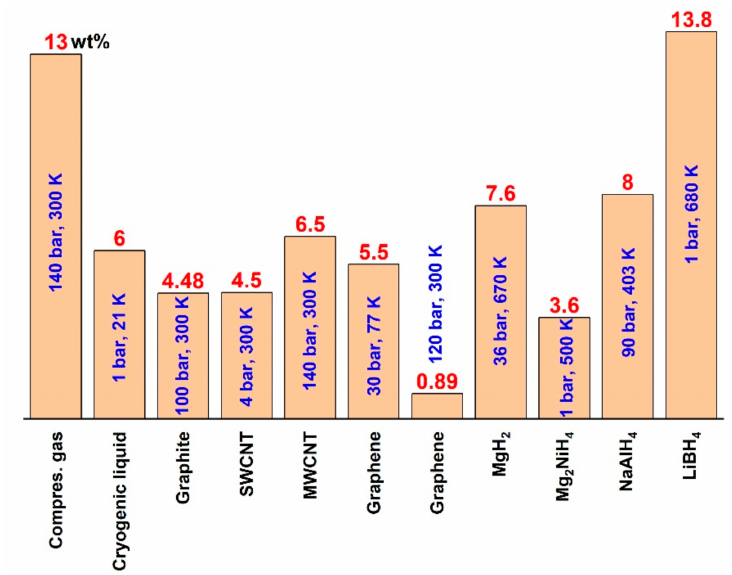
Figure 1. Hydrogen storage capacity (wt%) for some important materials. The kinetic conditions for hydrogen storage are